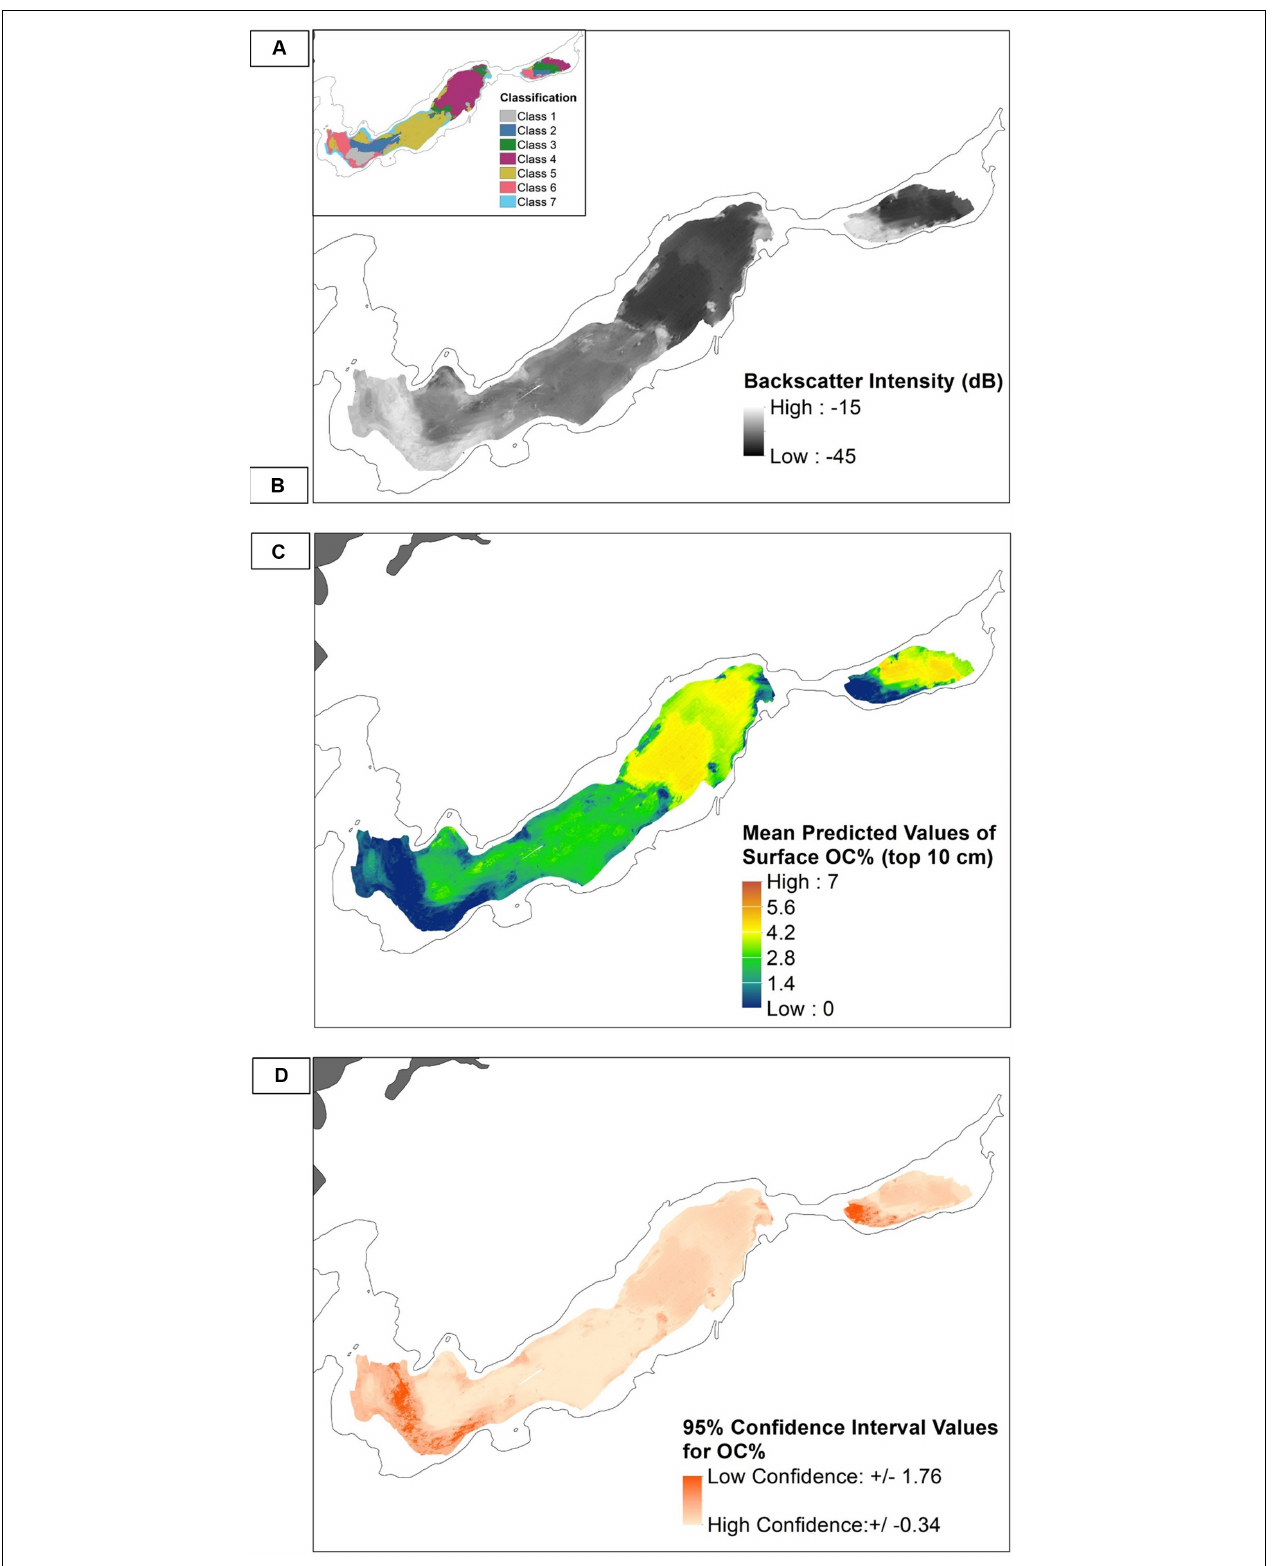
FIGURE 10 | Loch Creran surface sediments; (A) Iso-cluster Classified areas; (B) Backscatter (dB) results from MBES survey, (C) Spatially predicted map of OC% based on the linear regression correlation found between backscatter and OC% and (D) Spatial map of confidence intervals for predicted OC% values.